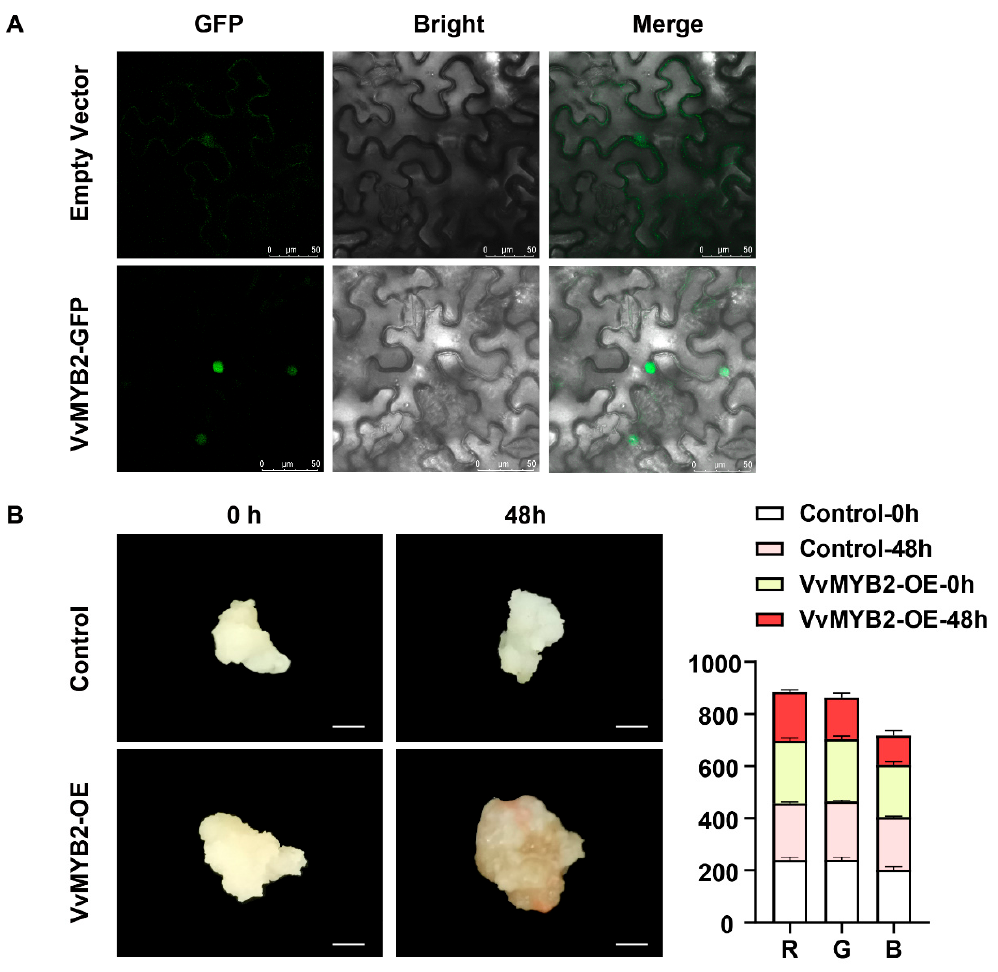
Figure 6. ( A ) Subcellular localization of VvMYB2. ( B ) Instantaneous transformation of VvMYB2 in grape callus and statistics of color change. Bar = 1 cm.